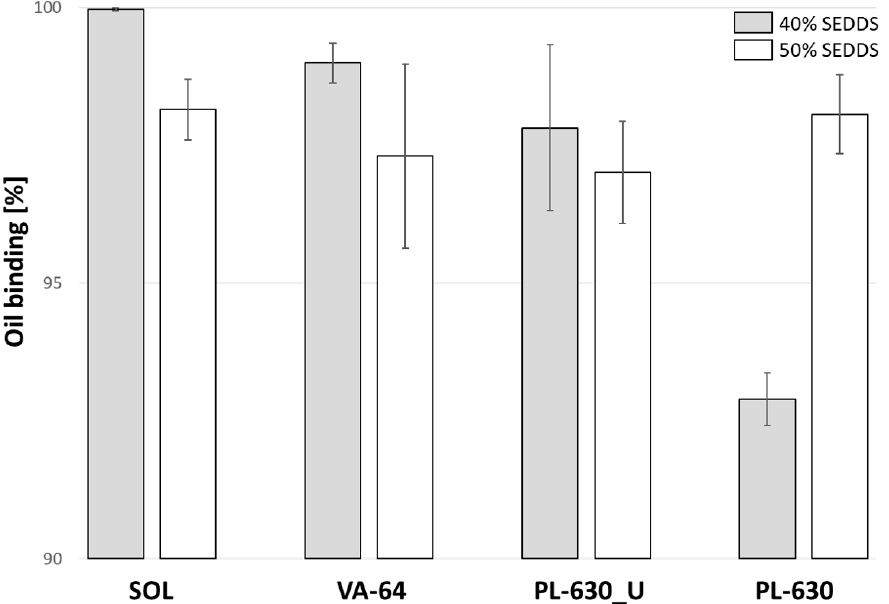
Figure 2. Oil-binding capacity of 40% w / w SEDDS in 60% w / w polymer (grey) and 50% w / w SEDDS in 50% w / w polymer (white). The polymers used were SOL, VA-64, PL-630_U, and PL-630. Data are shown as mean ± SD ( n =3).